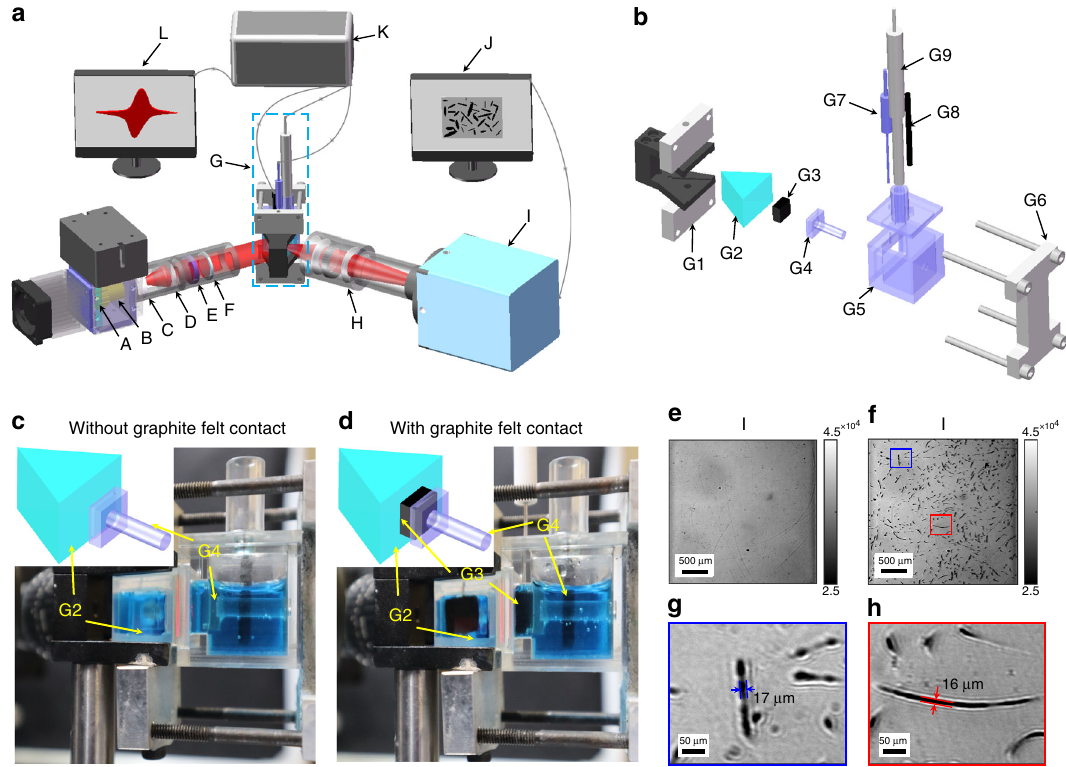
Fig. 1 Total internal re fl ection imaging (TIRi) sensor system for current density detection of electrode. a Schematic of the TIRi sensor system. A: LED; B: objective lens; C: aperture; D: achromatic lens; E: bandpass fi lter; F: linear polarizer; G: reservoir-coupled sensor module (RCS); H: imaging lens; I: charge coupled device (CCD); J: computer for receiving images from the CCD; K: electrochemical workstation (EW); L: computer for receiving cyclic voltammetry (CV) curves from the EW. b Expanded view of the RCS in a . G1: prism holder; G2: prism; G3: graphite felt; G4: strut; G5: fl uid reservoir; G6: reservoir holder; G7: platinum electrode; G8: graphite rod; G9: saturated calomel electrode. c Snapshot and schematic (inset) of RCS without graphite felt contact. d Snapshot and schematic (inset) of RCS with graphite felt contact. e Image captured by CCD in case c . f Image captured by CCD in case d . g, h Enlarged views of rectangular regions marked in f